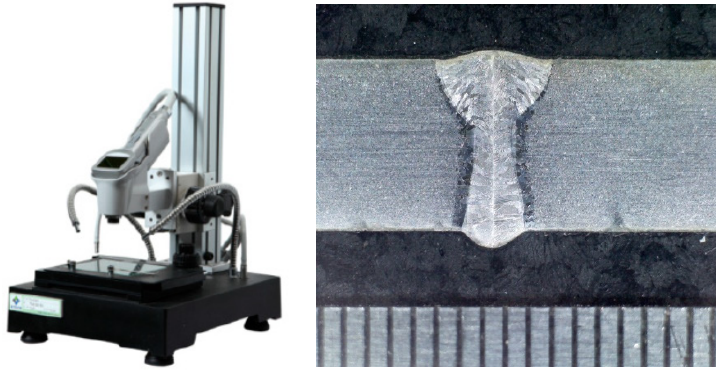
Figure 4. Optical microscope equipment and example of cross-section examination.